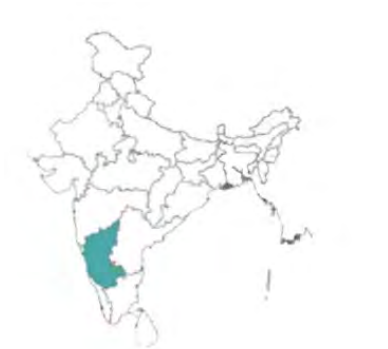
Figure 2. India map showing Karnataka